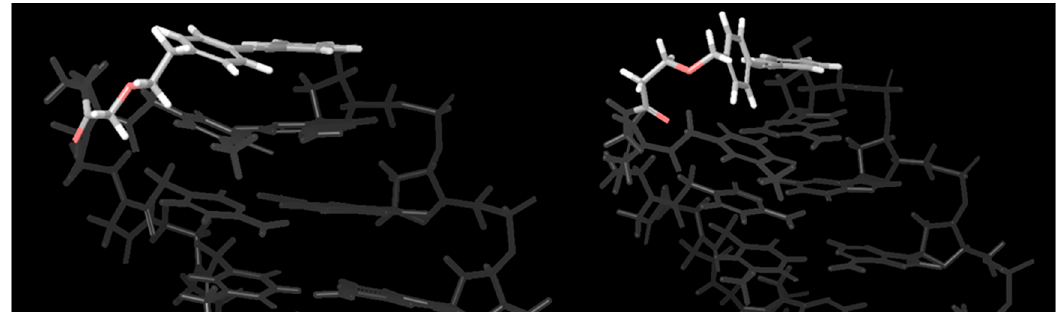
Figure 4. Molecular docking simulation of the tolane-PNA/DNA duplex conformation. Left: tolane 6 formed a favorable stacking conformation with the terminal base pair of the PNA/DNA duplex via its flexible ether linker. Right: tolane 7 was unable to form a stacking interaction with the N-terminal base pair due to the rigidity of the amide linker. The PNA/DNA duplex structures were obtained as 1PDT from the PDB data bank and the conformational search was performed with the OPLS2005 force field and gradient termination at 0.001 kJ/mol-Å (MacroModel, 2010).